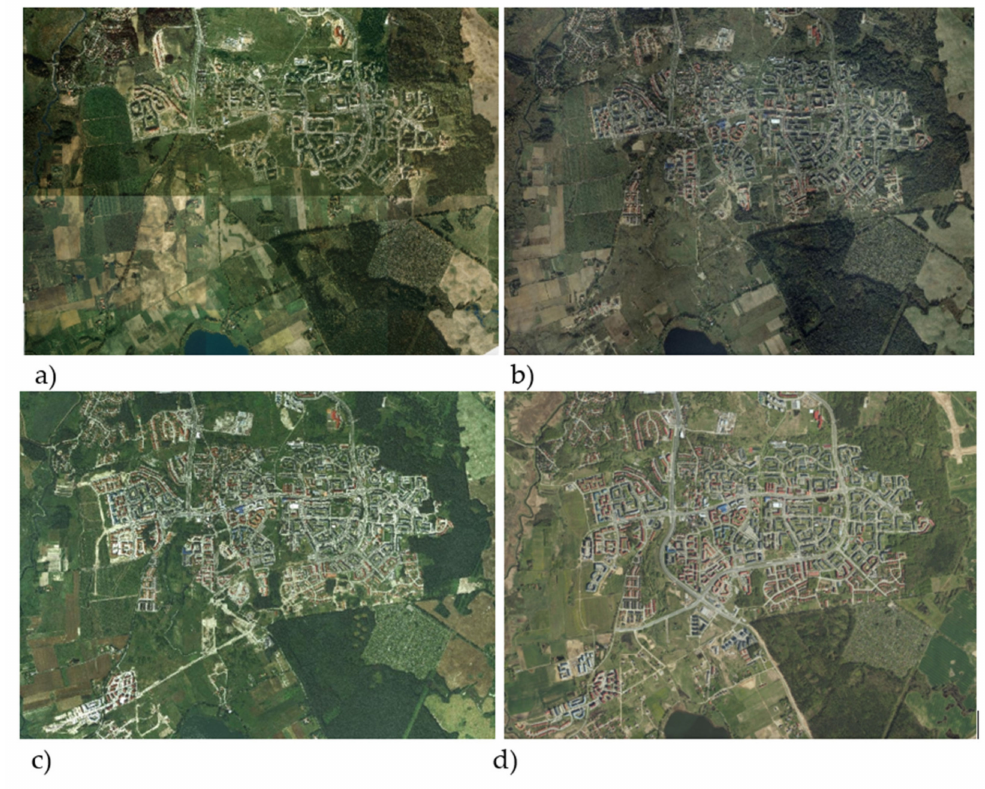
Figure 6. An orthophotomap of the southern part of Olsztyn: ( a )—1995, ( b )—2005, ( c )—2009, ( d )—2017. Source: https://msipmo.olsztyn.eu/imap/ (accessed on 20 July